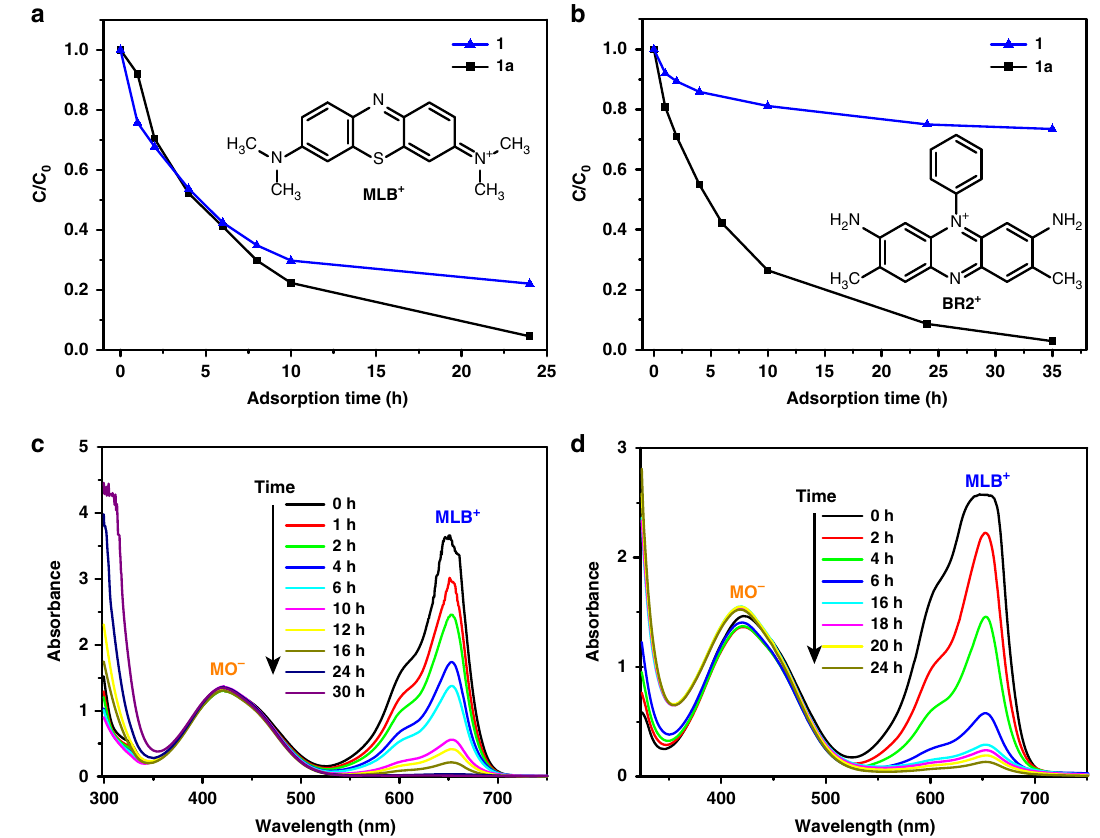
Fig. 4 Selective adsorption of 1 and 1a for dye molecules. a , b Concentration changes of cationic dyes MLB + and BR2 + with time as determined by the UV – Vis absorbance at a selected wavelength. c , d Temporal evolution of UV – Vis absorption spectra of a MLB + /MO − mixture in the presence of 1 and 1a